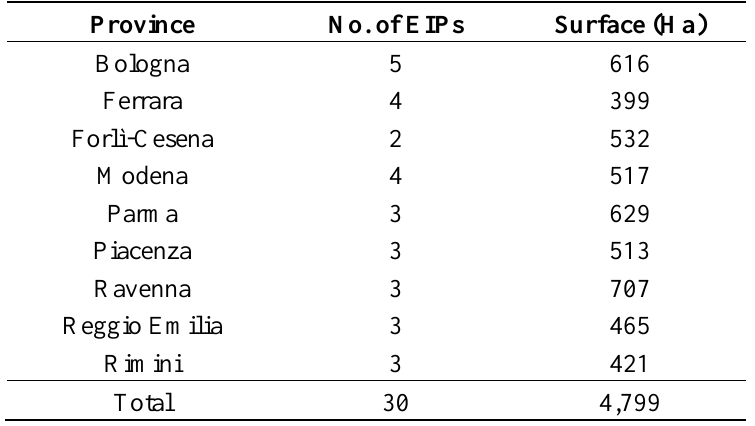
Table 6. Eco-industrial parks in the Emilia-Romagna Region, by Province (data source: Ervet 2010